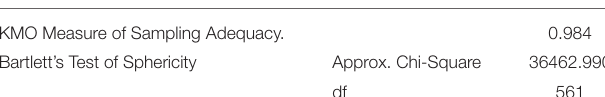
TABLE 3 | Exploratory factor analysis for finance and trade college graduate employability. Kaiser-Meyer-Olkin (KMO) and Bartlett’s Test of Sphericity KMO Measure of Sampling Adequacy.